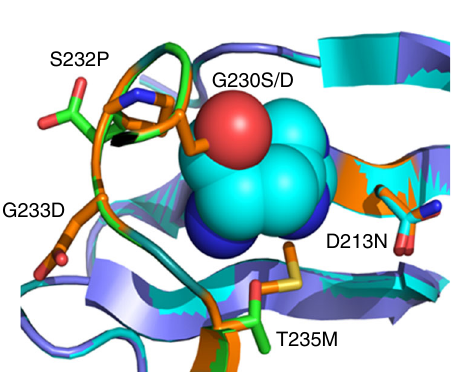
Fig. 5 Amino acid substitutions in the ATP-phosphoribosyltransferase (HisG). Location of the amino acid substitutions in the allosteric L -histidine binding site in HisG of C. glutamicum . The structure model for HisG of C. glutamicum was built based on the HisG crystal structure of the closely related Mycobacterium tuberculosis 26 (PDB code: 1NH8) using SWISS- MODEL 48 .